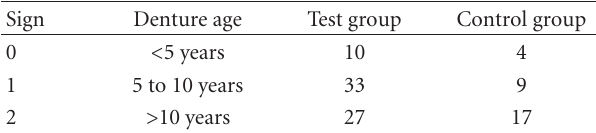
Table 1: Distribution of patients according to denture age. Sign